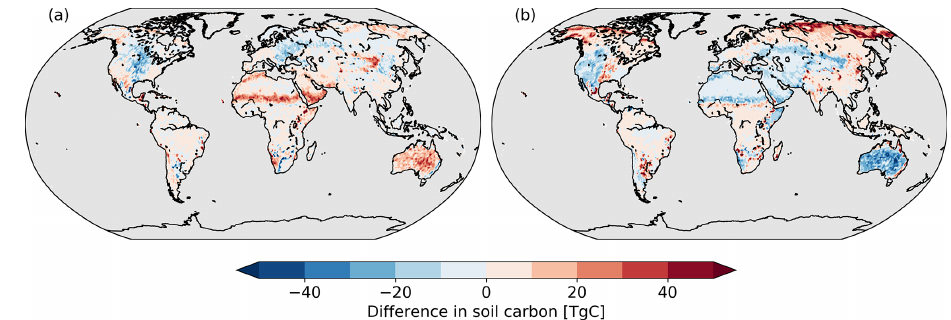
Figure 9. Difference in soil carbon for (a) Noextremes vegetation (b) and Hotdry vegetation from the Control